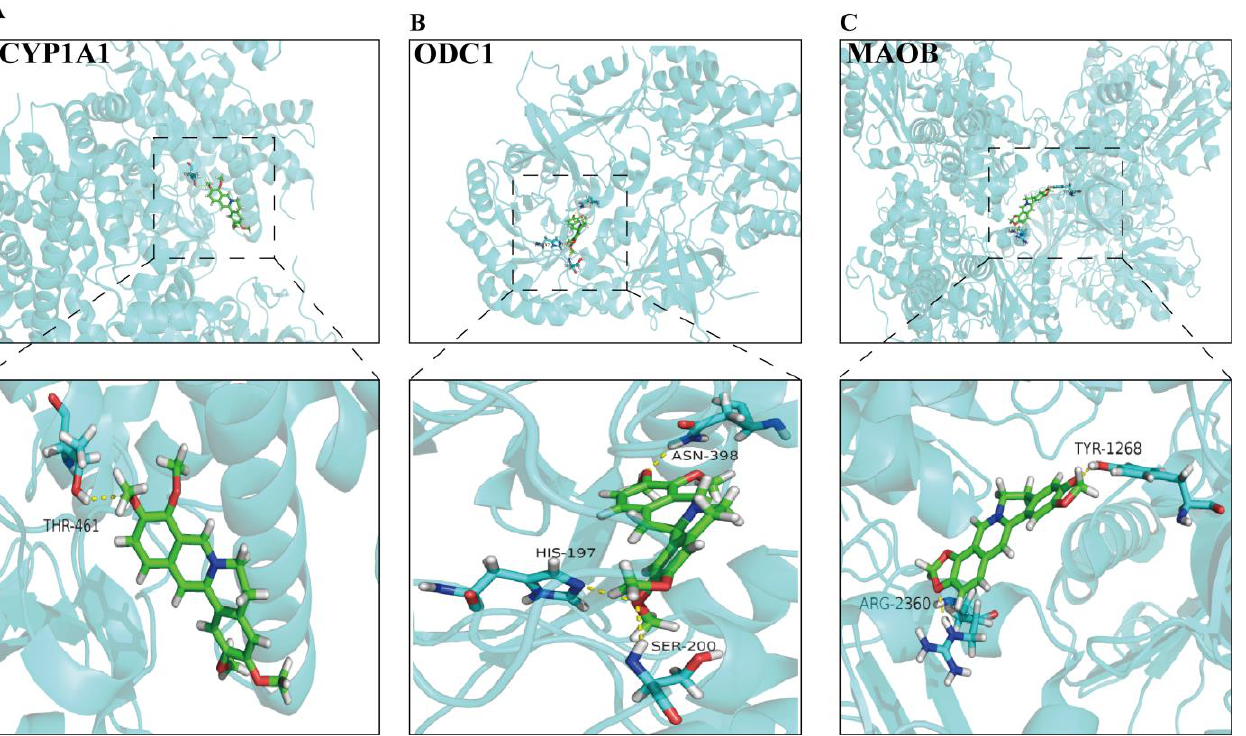
Figure 8. Interaction diagrams of active ingredients and key targets were scored by SYBYL-X ver- sion 2.0 and PyMoL. ( A ) Palmatine; ( B ) Tetrahydropalmatine; ( C ) Dehydrocavidine. 2.0 and PyMoL. ( A ) Palmatine; ( B ) Tetrahydropalmatine; ( C )